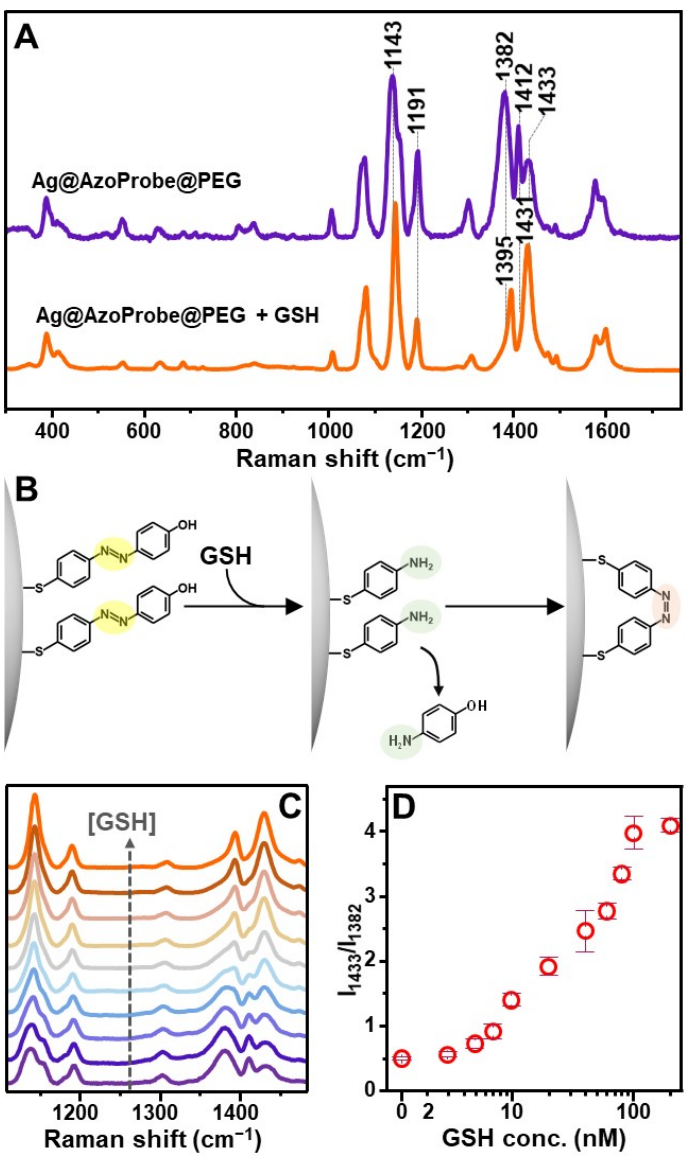
Figure 4. ( A ) SERS spectra of Ag@AzoProbe@PEG clusters before and after mixing with GSH (100 nM). ( B ) Outline of the proposed detection mechanism. ( C ) From bottom to top, SERS spectra of Ag@AzoProbe@PEG clusters at increasing GSH concentration (0, 5, 7, 10, 20, 40, 60, 80, 100, and 200 nM). ( D ) Intensity ratio I 1433 /I 1382 vs. GSH concentration (logarithmic scale).